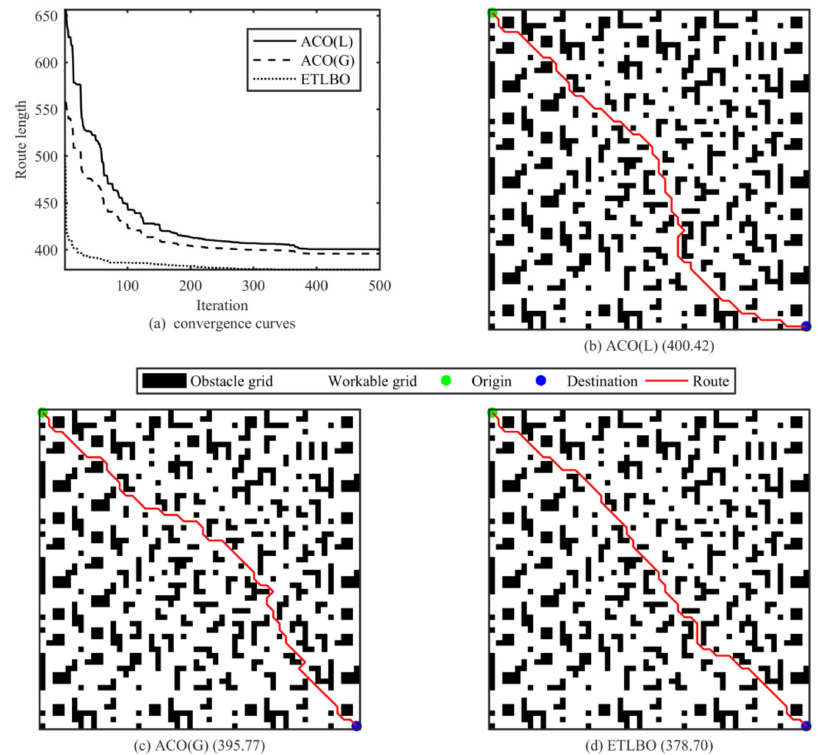
Figure 9. Best solution information of instance 50 × 50.